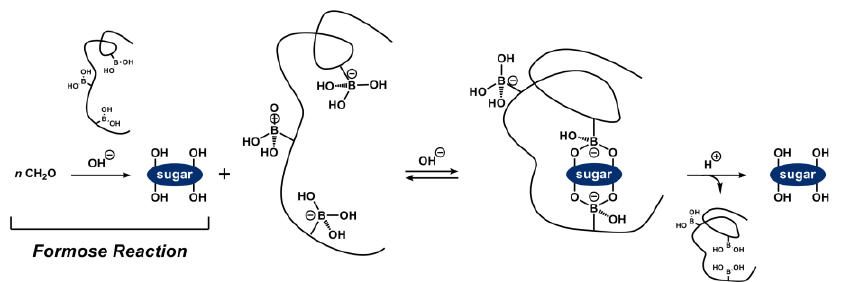
Figure 7. Conceptual illustration of formose reaction in the presence of a boronic acid polymer, in which the polymer stabilizes the product via ester formation, leading to an enhanced